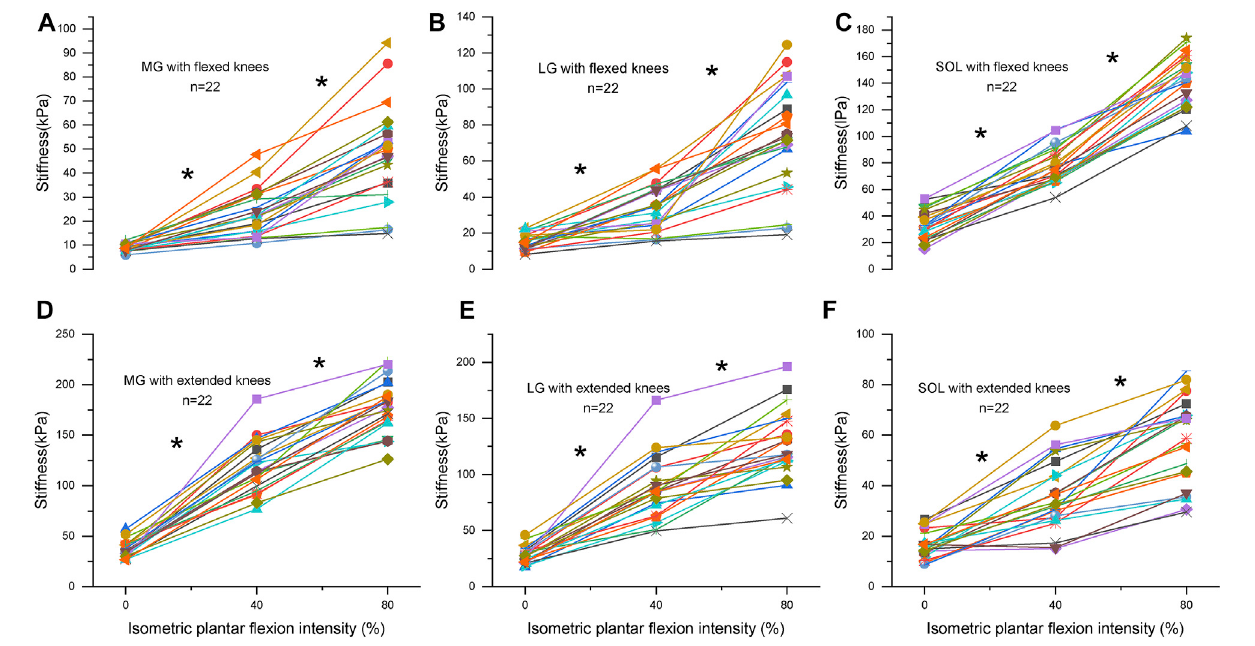
FIGURE 3 | (A – C) represent the stiffness of the medial gastrocnemius (MG), lateral gastrocnemius (LG) and soleus (SOL) with fl exed knees, respectively. (D – F) represent the stiffness of the MG, LG and SOL with extended knees, respectively. Changes in stiffness is related to isometric contraction intensity (0%: no contraction, 40%,and 80%ofmaximumvoluntaryisometric contraction)fortricepssuraemusclesin22subjects.Eachsubjectisrepresented byadifferentsymbol.*Signi fi cant( p < 0.05) at different contraction intensities.